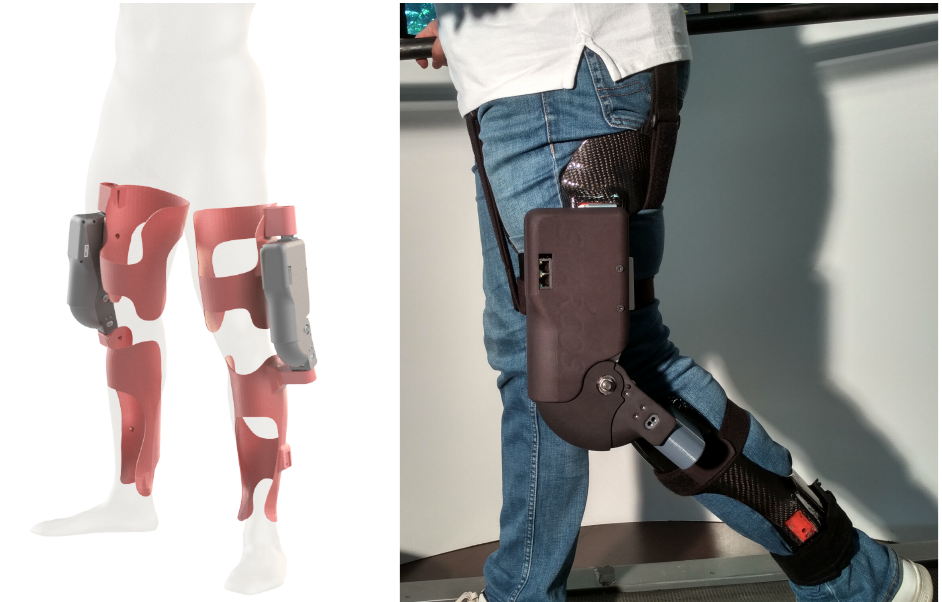
Figure 20. Prototype of an assistive knee orthosis developed with the SMARCOS. The actuator is rigidly interfaced with two generic cuffs in order to be attached to the human